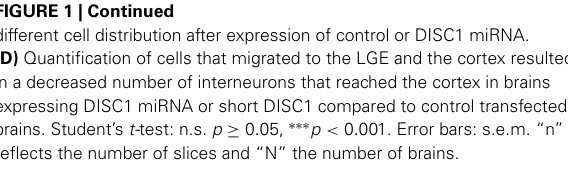
FIGURE 1 | Continued different cell distribution after expression of control or DISC1 miRNA. (D) Quantification of cells that migrated to the LGE and the cortex resulted in a decreased number of interneurons that reached the cortex in brains expressing DISC1 miRNA or short DISC1 compared to control transfected brains. Student’s t- test: n.s. p ≥ 0 . 05, ∗∗∗ p < 0 . 001. Error bars: s.e.m. “n” reflects the number of slices and “N” the number of brains.